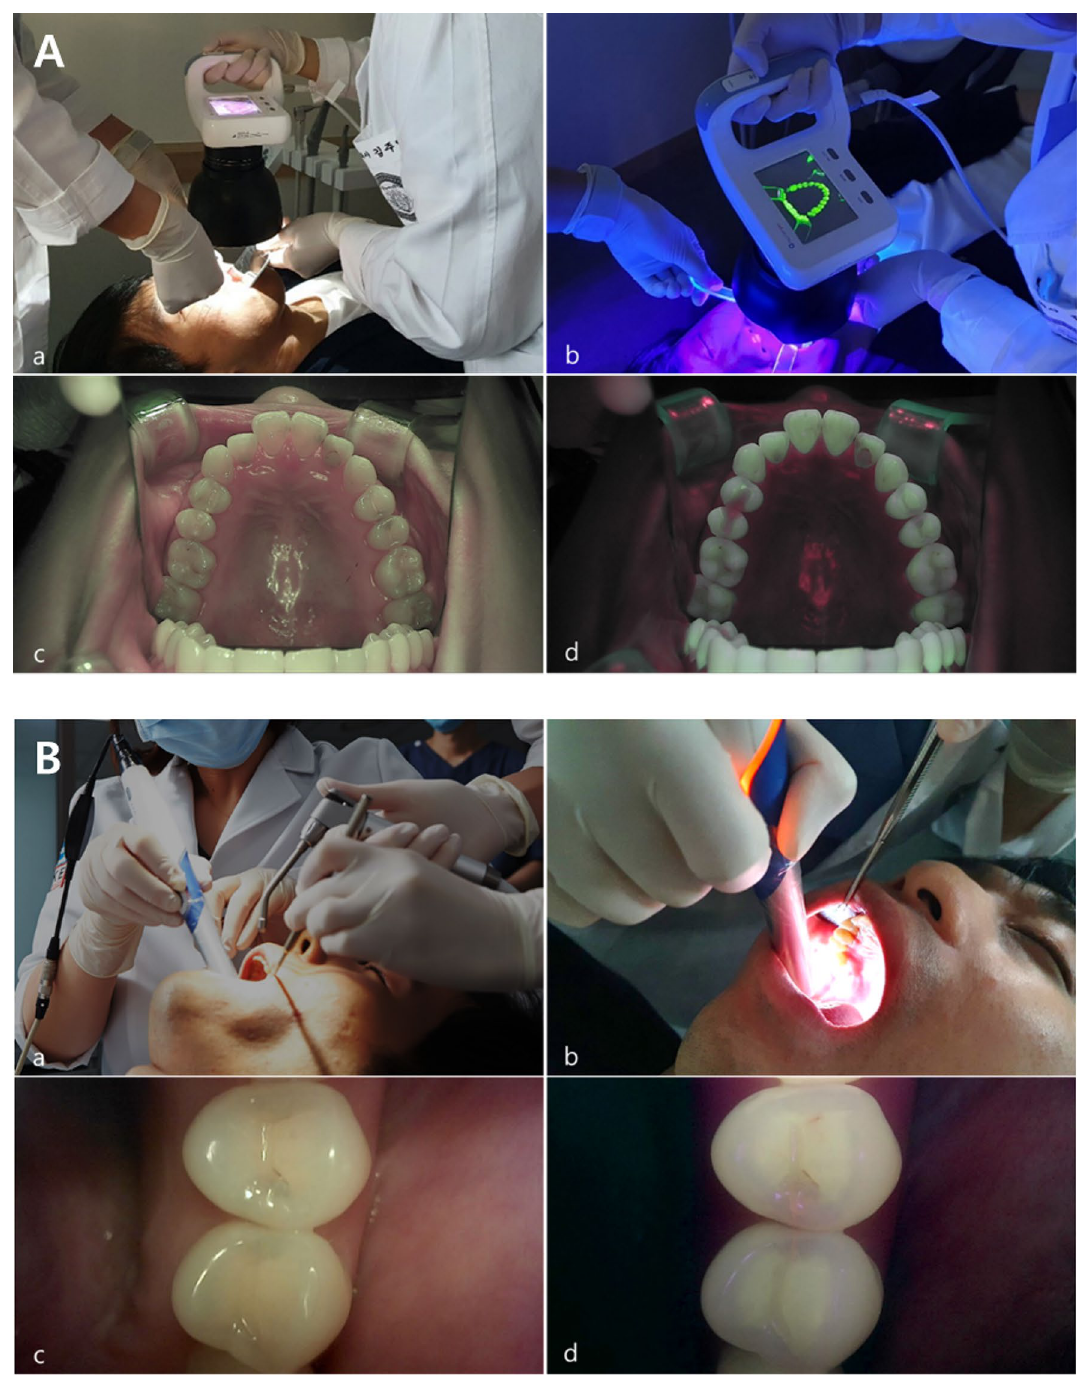
Figure 4. ( A ) White-light and fluorescent images of the occlusal surface of the maxilla or mandible captured using a Qraycam Pro® (QP, AIOBIO, Seoul, Republic of Korea). (a, b) A trained examiner using a Quantitative light-induced fluorescence (QLF) system in a dark room to maintain the image quality. This device is equipped with a metal tube that blocks external light to prevent contamination of the fluorescent image. (c) White-light image (d) Fluorescent image. ( B ) (a, b) QLF images of the occlusal surface of the examined tooth captured using a Qraypen C® (QC, AIOBIO, Seoul, Republic of Korea). (c) White-light image (d) Fluorescent image. ( C ) QA2 version 1.25 (Inspektor Research system BV, Amsterdam, The Netherlands). QA2 provides the QLF parameters (ΔF max , ΔF aver. , ΔR max , ΔR aver. ) of the area of interest (AOI); (a, b) Quantitative analyses of QP and QC images,